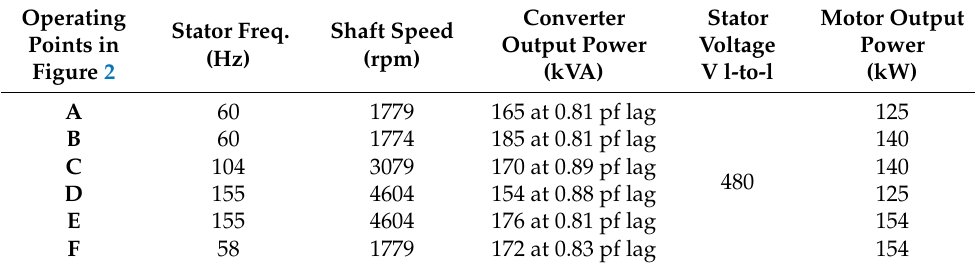
Table 3. Quantification of all operating points in Figure